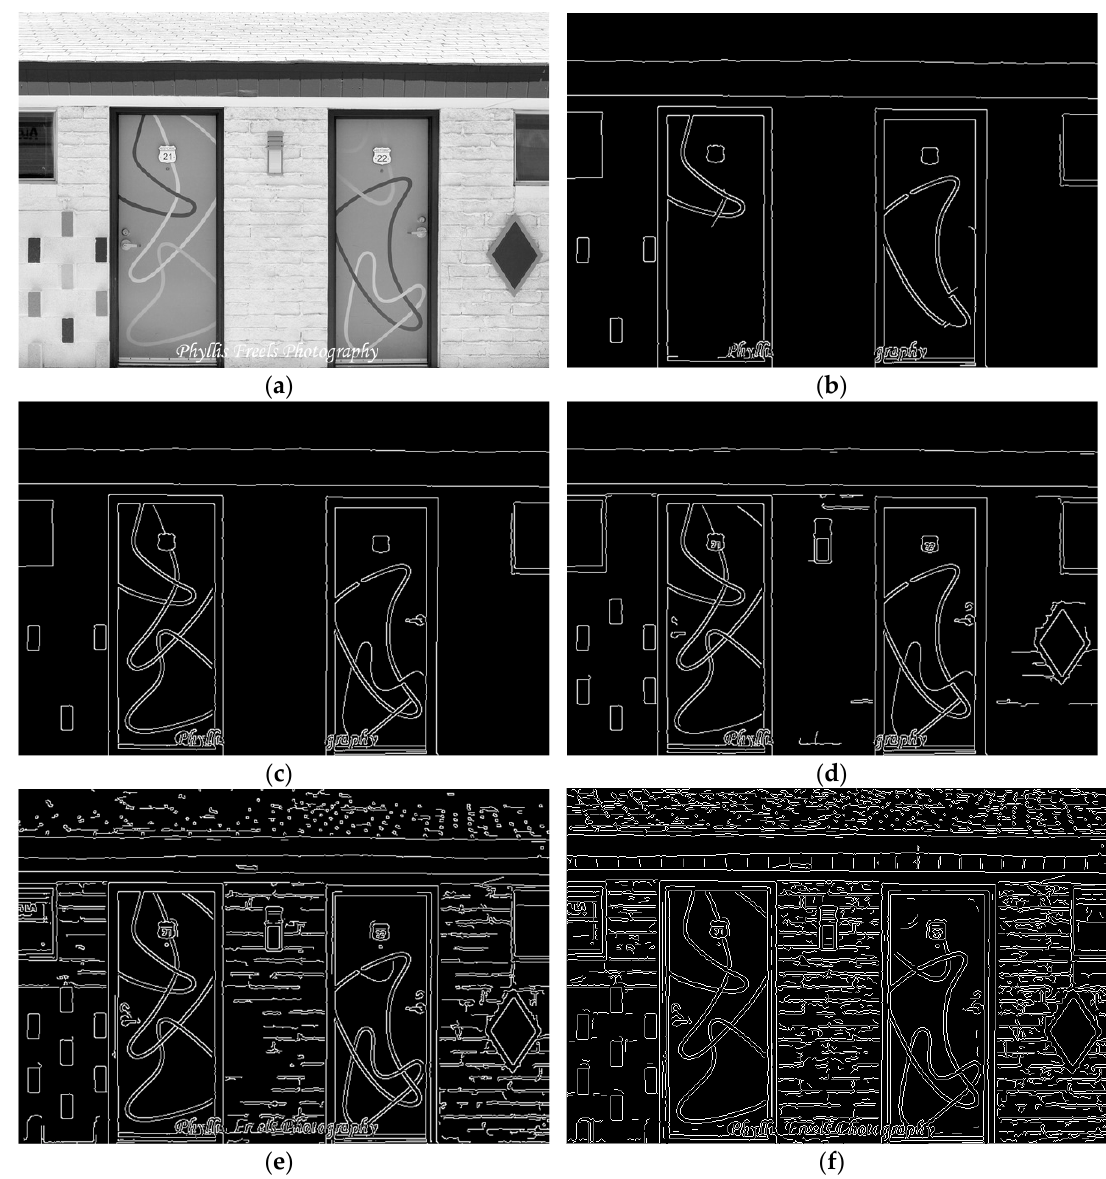
Figure 14. Hotel image comparison results of different methods. ( a ) Original image (640 × 427) [17]; ( b ) Gao and Liu’s method (TH H = 233, TH L = 117); ( c ) Song et al. proposed method (TH H = 233, TH L = 38); ( d ) Saheba et al.’s method (TH H = 141, TH L = 41); ( e ) Li and Zhang’s method (TH H = 62, TH L = 24); ( f )